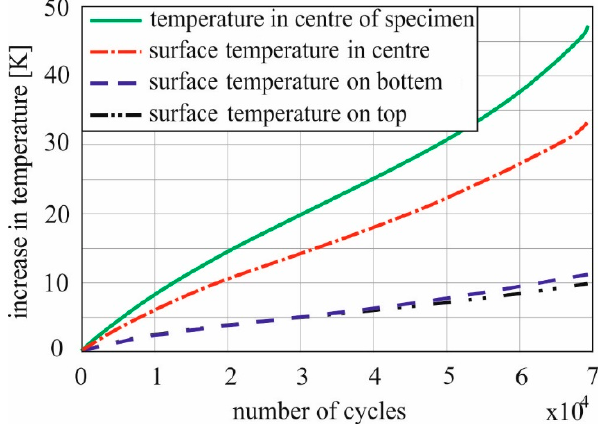
Figure 4. Temperature development of one test specimen made of UHPC 1; test conditions: test frequency f P = 10 Hz, relation between lower and upper stress level S c,min /S c,max = 0.1/0.7.